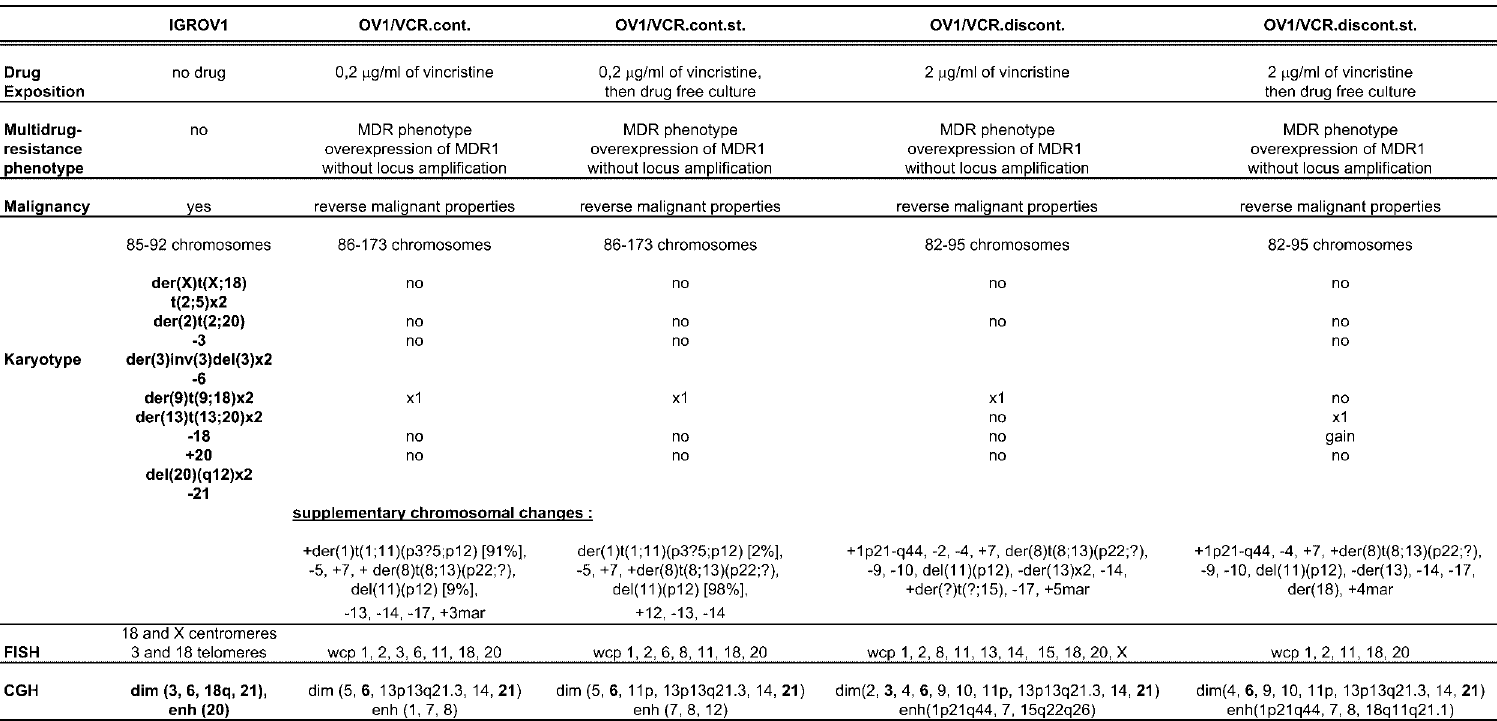
Karyotype, CGH and FISH results of OV1/VCR sublines. The cellular properties and chromosomal changes compared to Igrov1 are presented. “no” means absence. The gray areas and the bold types mean that the chromosomal abnormality was conserved (compared to Igrov1 cell